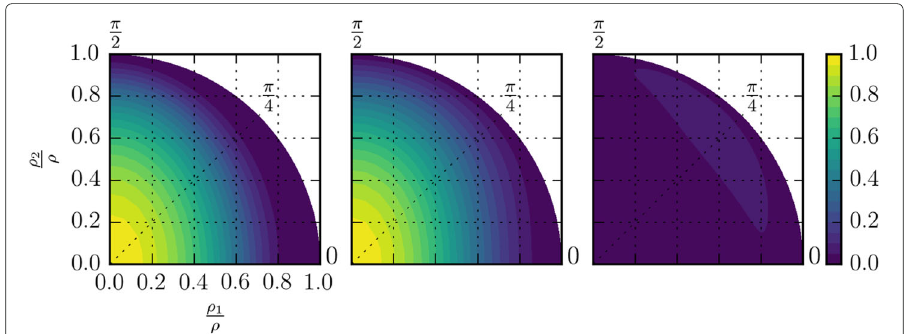
Fig. 12 Left: cross slip annihilation function f ann of total dislocation density in CDD ( 1 ) plotted in polar coordinates with the first dislocation moment M ( 1 ) as distance to the origin and the GND angle ϕ ρ . The equivalent Cartesian coordinates are the screw and edge components of the normalized GND vector (cid:8) ρ ( 1 ) = ρ /ρ . Middle: analytical approximation of the annihilation rate f (cid:18) (cid:19) (cid:12) (cid:11) 2 | ρ | 1 − . Right: the absolute error of the ρ